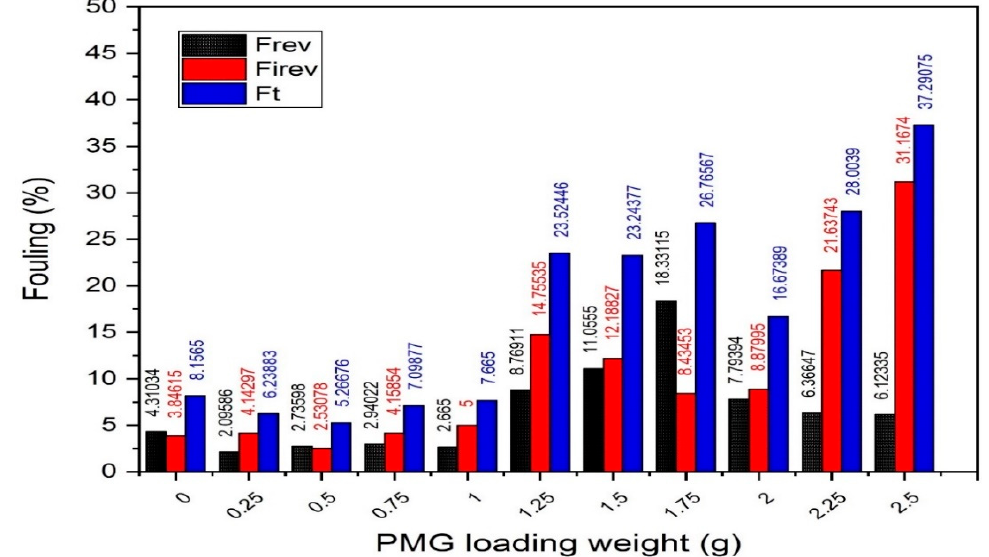
Figure 14. Total fouling, reversible fouling, and irreversible fouling of nanocomposite membranes against BSA protein model.